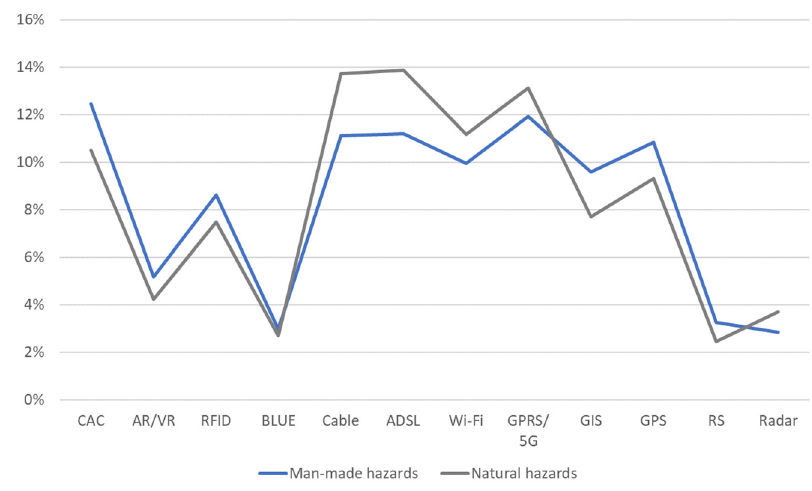
Figure 11. Vulnerabilities of ICTs against natural and man-made hazards.